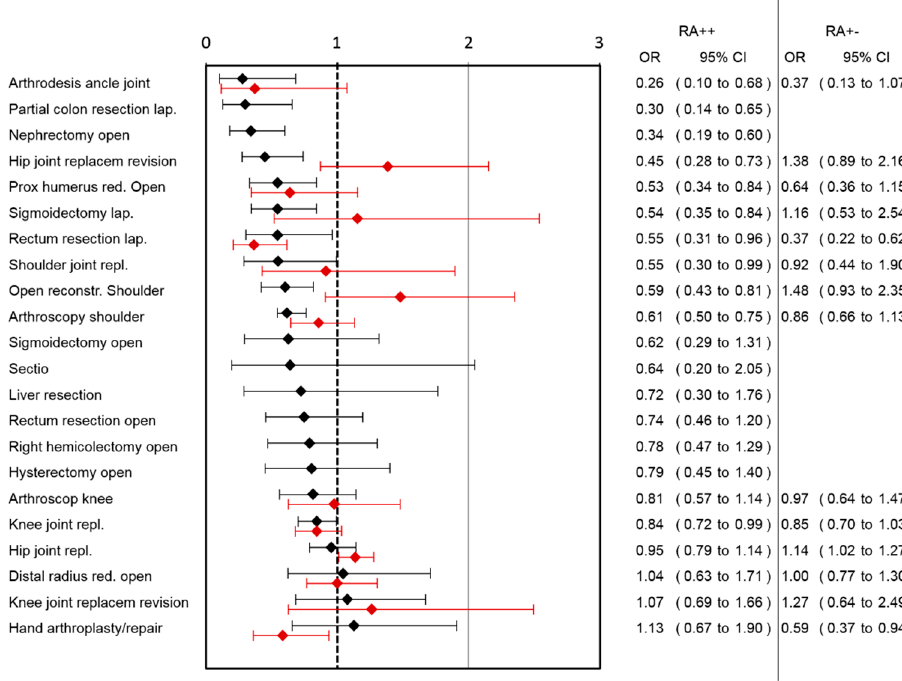
Figure 2. Association of RA with pain-associated impairment of mobilization in different surgical categories. Patients with continuous (RA++; black lines) or single-shot RA (RA+ − ; red lines) are compared to patients without RA (RA −− ). OR and corresponding 95% confidence intervals for both analyses are shown.